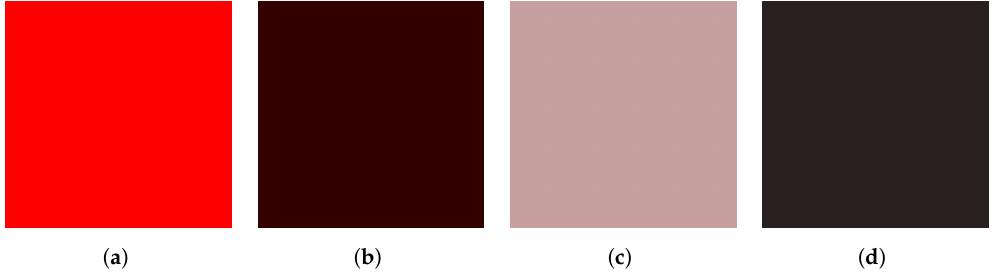
Figure 5. Mean observed color for color-based error condition contexts. ( a ) Default, ( b ) Color with night/low light, ( c ) Color with fogginess, and ( d ) Color with night and